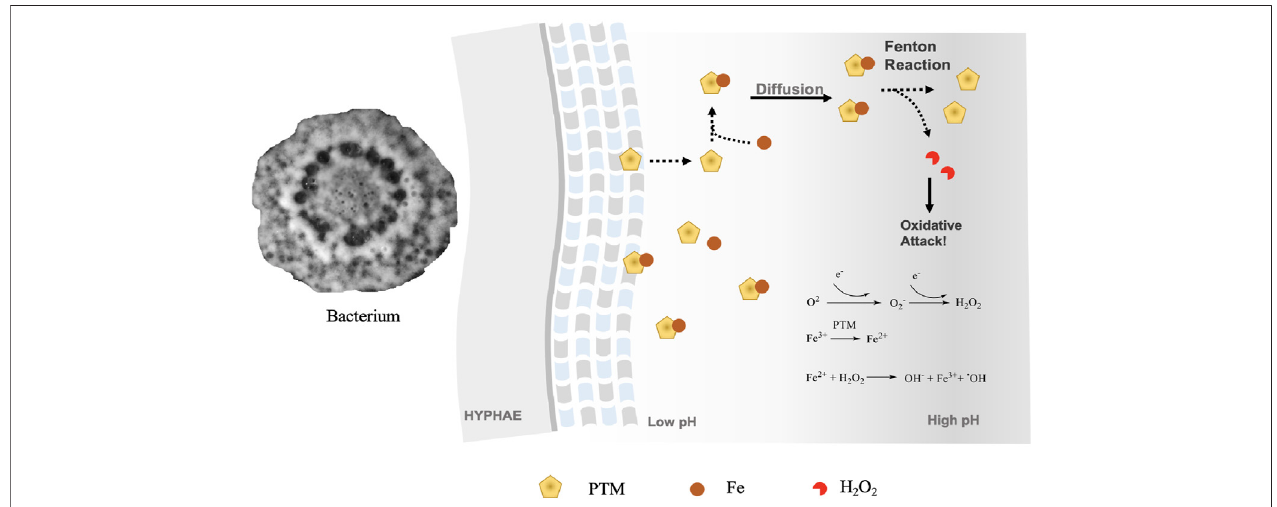
FIGURE4| Proposedmode-of-actionofPTMsasmetallophoresandantibiotics.BacteriasecretePTMsintoextracellularenvironment.Asthediffusionoccursand the pH lowers, PTMs start to reduce Fe 3+ and initiate a Fenton ’ s reaction. An oxidative attack could occur, where PTMs function as antibiotics.